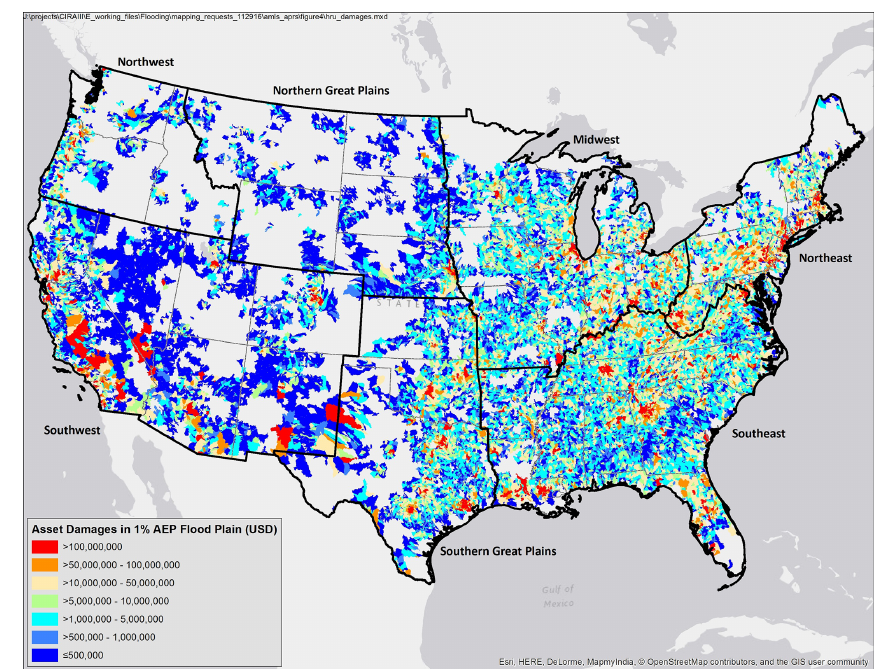
Figure 4. Total asset damages from a 1% AEP flood event in each of the HRUs in the CONUS. Values are in 2014